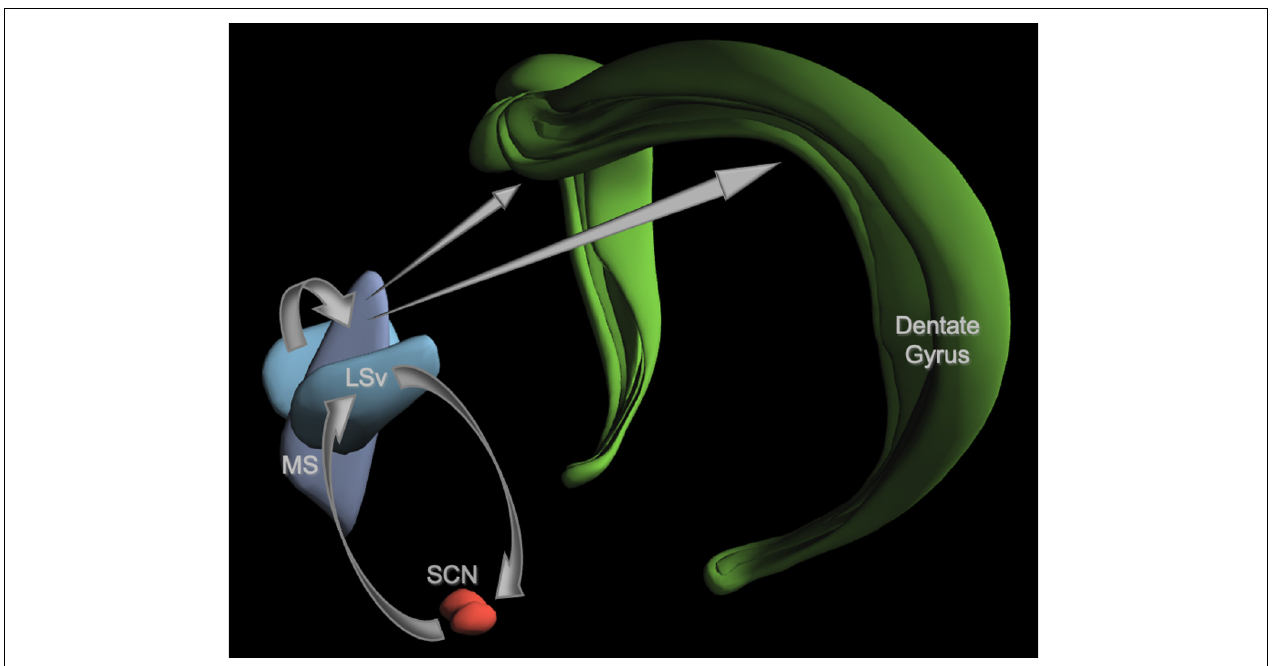
FIGURE 5 | A neuroanatomical model of a proposed SCN-septum-dentate circuit. For the sake of clarity, only the elements of the model discussed in the text are illustrated here. The projections from each structure are shown as gray arrows. The SCN has reciprocal connections with the ventral lateral septum (LSv). GABAergic fibers from the LSv innervate the medial septum (MS) shown here without the diagonal band of Broca. MS fibers containing Ach, GABA, and glutamate project to all subregions of the hippocampus, but only the dentate gyrus is shown. Fibers from the LSv to the SCN are primarily vasopressinergic (VP). See text for details and citations. Image credit: Allen